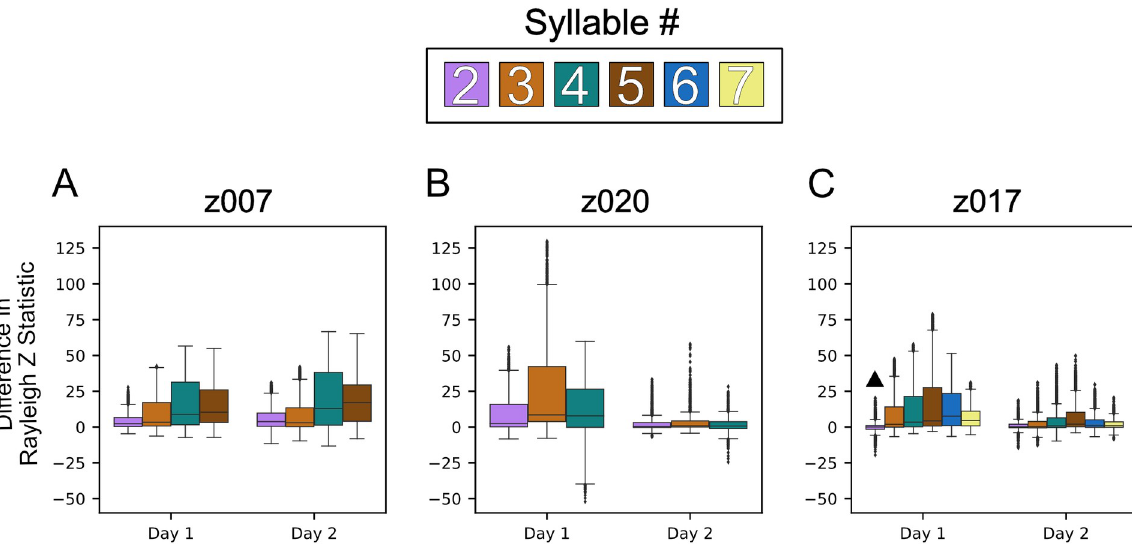
Fig 8. Phase preference to syllable onset is reflective of constitutive syllables rather than of the larger motif structure. Box plots of the differences in Rayleigh Statistic between the syllable aligned ITPC and the ITPC aligned to that same syllable’s stereotyped onset time within the motif. Positive differences indicate greater phase consistency at the syllable aligned time versus that of the stereotyped time across LFP frequencies (4–8 Hz, 8–12 Hz, 25–35 Hz, 35–50 Hz, and 50–70 Hz). This difference was determined by first concatenating the Z statistic for each channel centered at the designated time point to get a vector of all partially overlapping frequencies for all channels. The vector of stereotyped alignment was then subtracted from the labeled onset alignment to achieve the difference for each frequency on every channel. This was repeated for all syllables, excluding the first, with each syllable represented by a specific color, as indicated. (A) Shows the results for the two high-yield days for z007, (B) shows the results for z020, and (C) shows the results for z017. All instances of each syllable that were preceded by the first syllable were used. To determine statistical significance, we used the one-sided Wilcoxon signed-rank test, with each frequency and channel pair. ▲ denotes that the comparison was not statistically significant when using the using the Benjamini-Hochberg False Discovery Rate. All other results p < 0.05 and q <